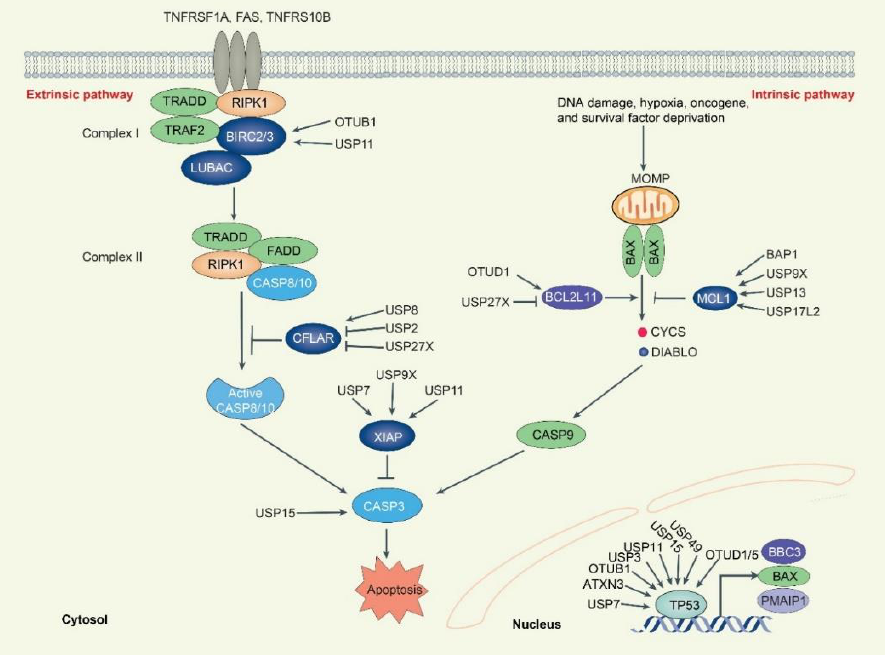
Figure 2. Overview of DUBs-mediated regulation of apoptosis. Activation of the extrinsic apoptotic pathway forms complex 1 (TRADD-TRAF2-RIPK1-BIRC2/3 complex). BIRC2/3 regulates RIPK1 and its autoubiquitination, whereas USP11 and OTUB1 deubiquitinate and stabilize BIRC2/3. Active RIPK1, TRADD, FADD and CASP8/10 form complex II to trigger the CASP8/10-CASP3 cascade of the apoptotic process. The CASP8/10 inhibitor CFLAR is rapidly renewed and deubiquitinated by DUB USP8. USP2 and USP27X reduce CFLAR expression by deubiquitinating their E3 ligases TRIM28 and ITCH. The intrinsic apoptotic pathway is controlled at the level of the BCL2 family. The pro-apoptotic protein BCL2L11 and the anti-apoptotic protein MCL1 proteins are tightly controlled by DUBs. While OTUD1 stabilizes BCL2L11, USP27x promotes the binding of BCL2L11 to E3 ligases to facilitate its degradation. Three DUBs (USP9X, USP13, and USP17L2) deubiquitinate MCL1, while BAP1 promotes MCL1 transcription through H2A deubiquitinate. The extrinsic/intrinsic apoptotic signal is incorporated into CASP3, which is deubiquitinated by USP15. The TP53 protein is responsible for the expression of BBR3, BAX, and PMAIP1, which cause apoptosis. The expression of TP53 is controlled by as many as nine DUBs, including USP3/7/11/15/22/49, OTUB1, OTUD1/5, and